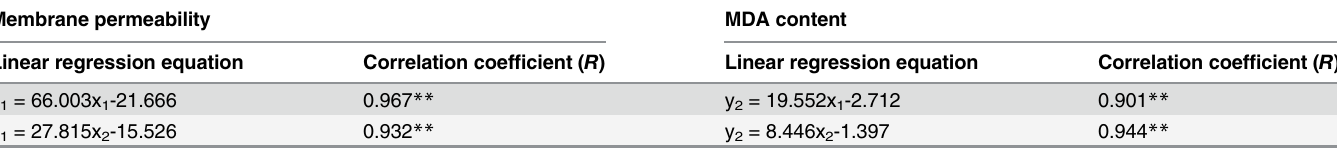
Table 2. Linear regression equation and correlation coefficient between the membrane permeability, MDA content and the H 2 O 2 and O 2- contents in soybean roots treated with La 3+ and AR.